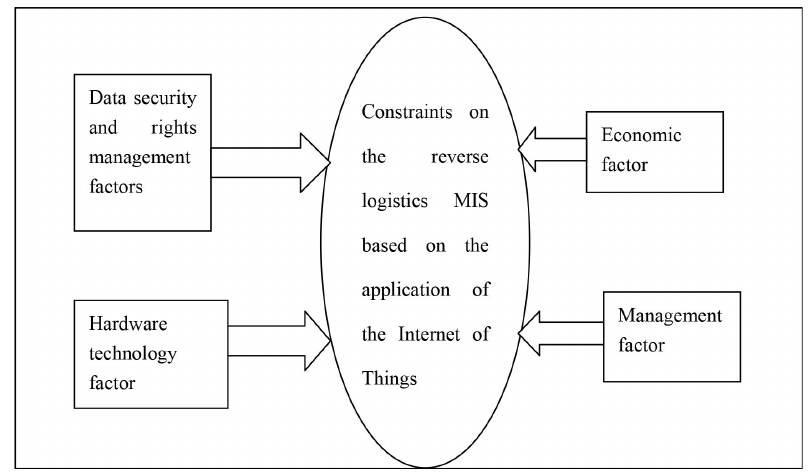
Figure 3. Constraints on the reverse logistics MIS based on the application of the Internet of Things